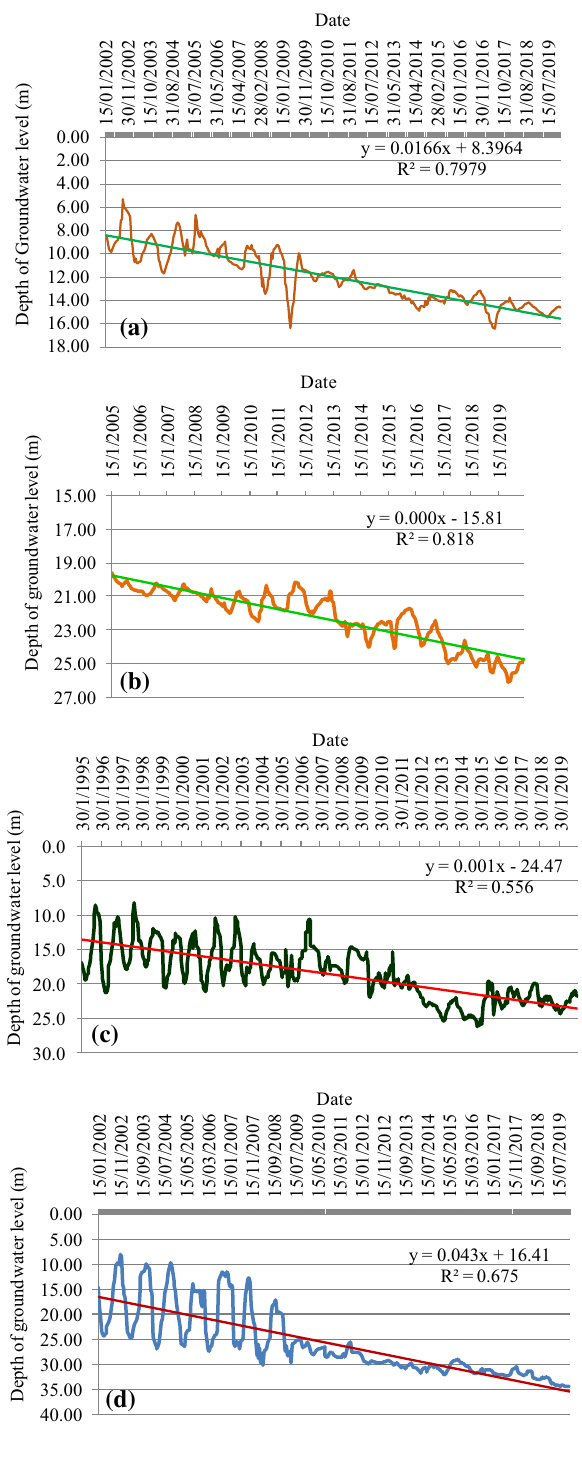
Fig. 12 a GWL Hydrograph at Haripur, Tanore upazila b GWL Hydrograph at Darajpur, Niamatpur upazila c GWL Hydrograph at Amtoli-1, Godagari upazila d GWL Hydrograph at Ratipur, Nachole